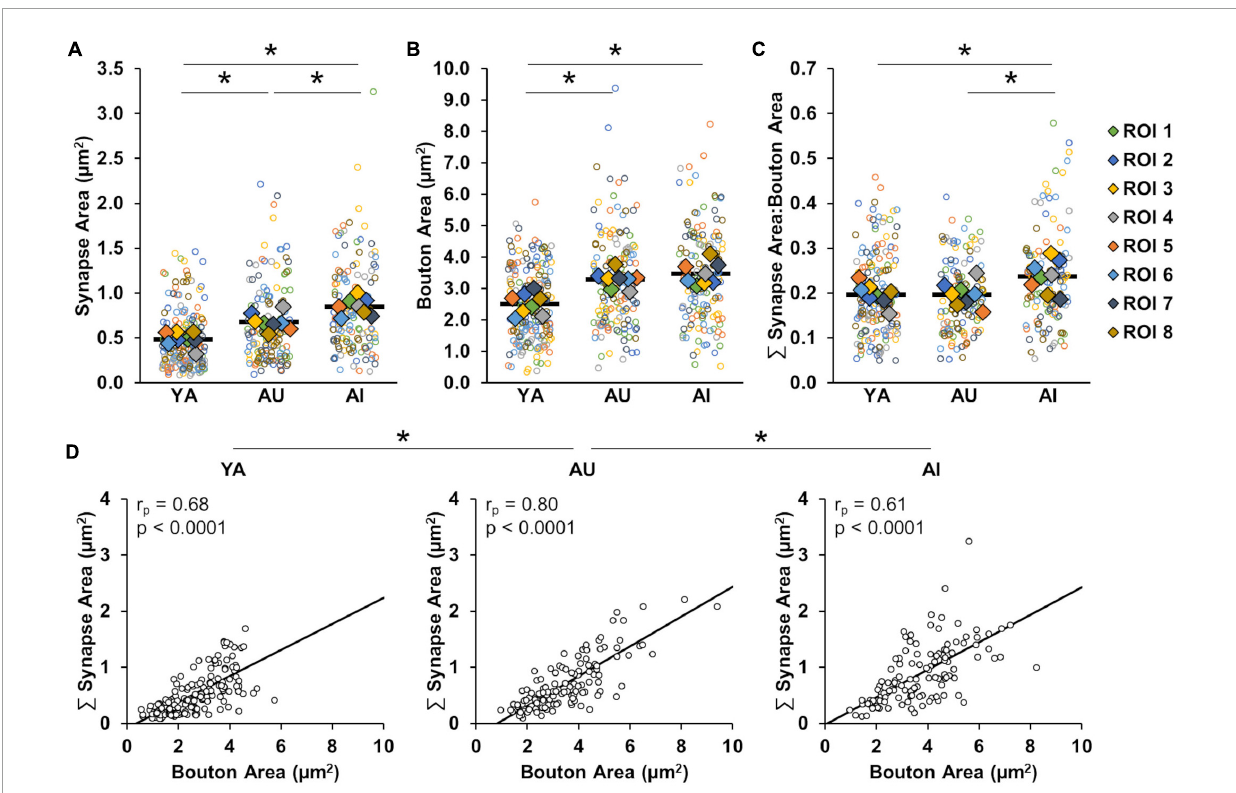
FIGURE4 Relationship between synapse surface area and bouton surface area is altered with working memory impairment. (A) Synapse surface area by animal. Aged marmosets have larger synapse surface areas than young marmosets, with a further increase associated with working memory impairment. (B) Bouton surface area by animal. Bouton surface area was increased in aged marmosets, but there was no further increase associated with working memory impairment. (C) Ratio of synapse surface area to bouton surface area. Age-related working memory impairment is uniquely associated with an increased ratio of synapse surface area to bouton surface area. (D) Correlations between bouton size and synapse size by animal. There are strong correlations between synapse size and bouton size in all conditions, with a significantly weaker correlation in the AI compared to the AU marmoset. In all figure panels, open circles show each individual data point. In (A–C) colored diamonds represent the average of measures taken in each of the ROIs, and horizontal black bars represent average across the ROIs. * p < 0.05.